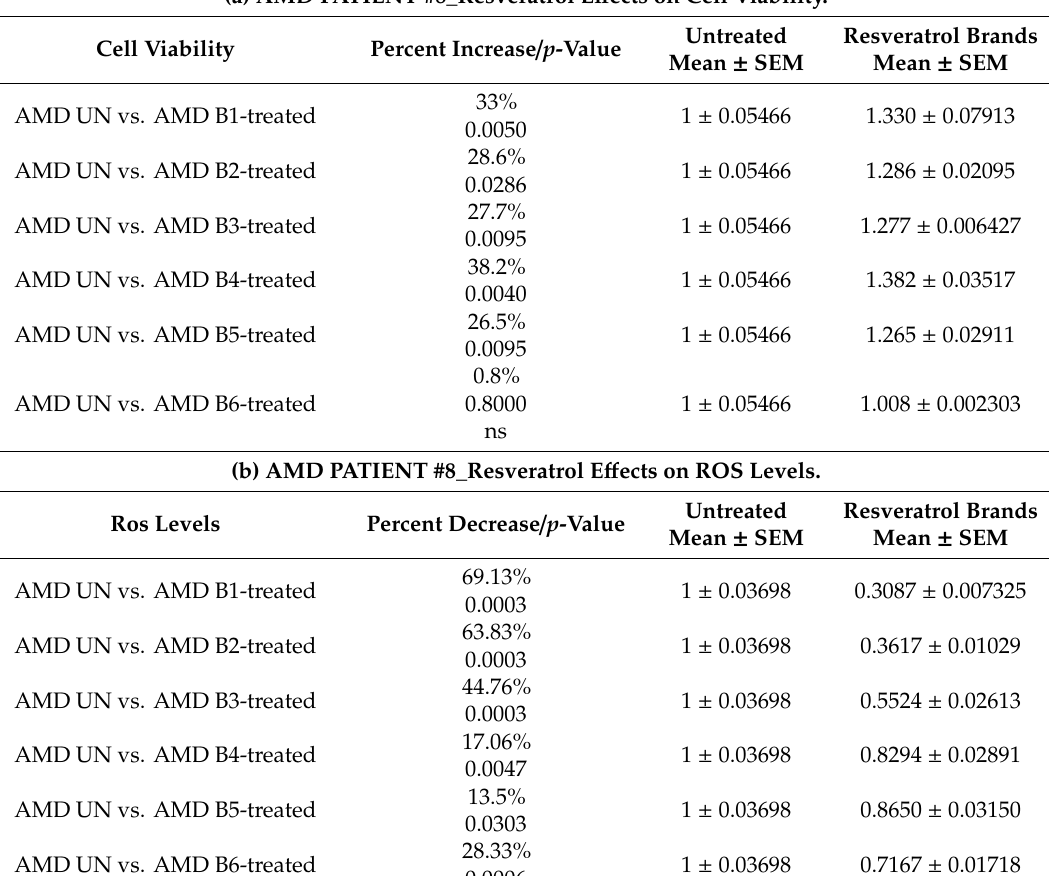
Table 10. E ff ects of resveratrol formulations on cell viability ( a ) and ROS levels ( b ) in AMD patient # 8. (a) AMD PATIENT #8_Resveratrol E ff ects on Cell